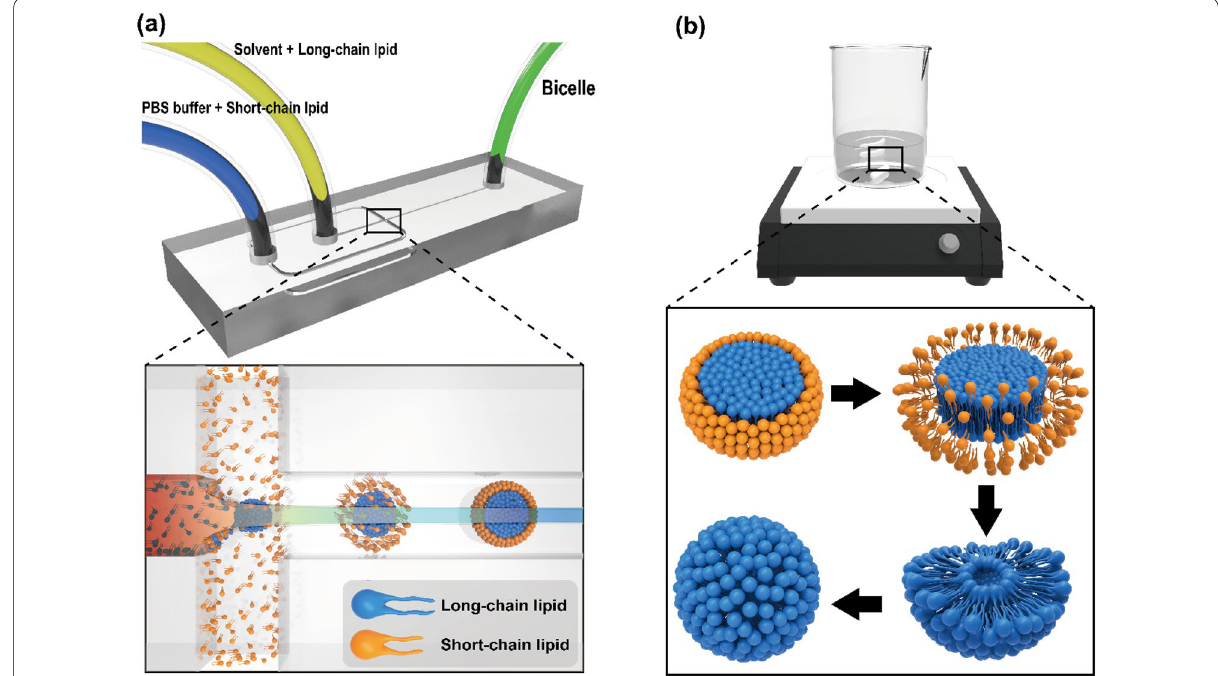
Fig. 1 Illustration of a the microfluidic method for bicelle synthesis and b bicelle to vesicle transition using simple dilution method. The flow rate ratio was fixed at 19 (the flow rate of solvent and buffer phase were 300 μL/h and 5700 μL/h, respectively). The microfluidic chip for bicelle preparation was composed of square channel (width and height of it was 80